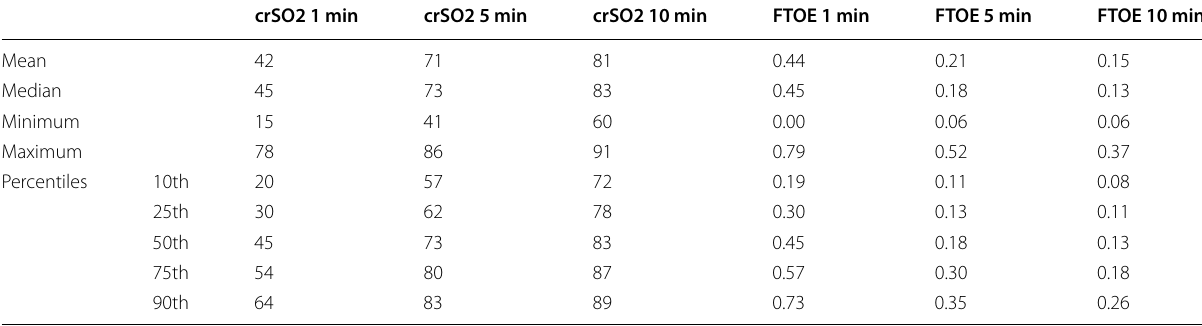
Table 2 Descriptive analysis of the studied cases according to cerebral regional oxygenation (crSO2) and fractional tissue